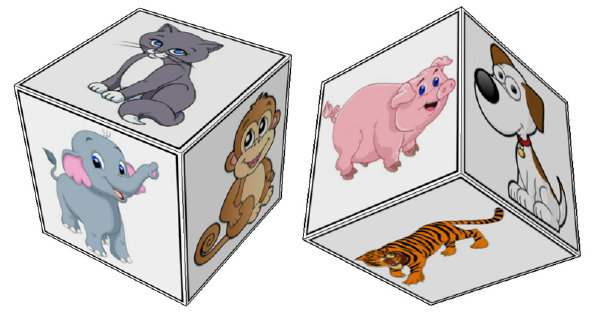
Figure 4: Cube with different animal pictures on its faces.